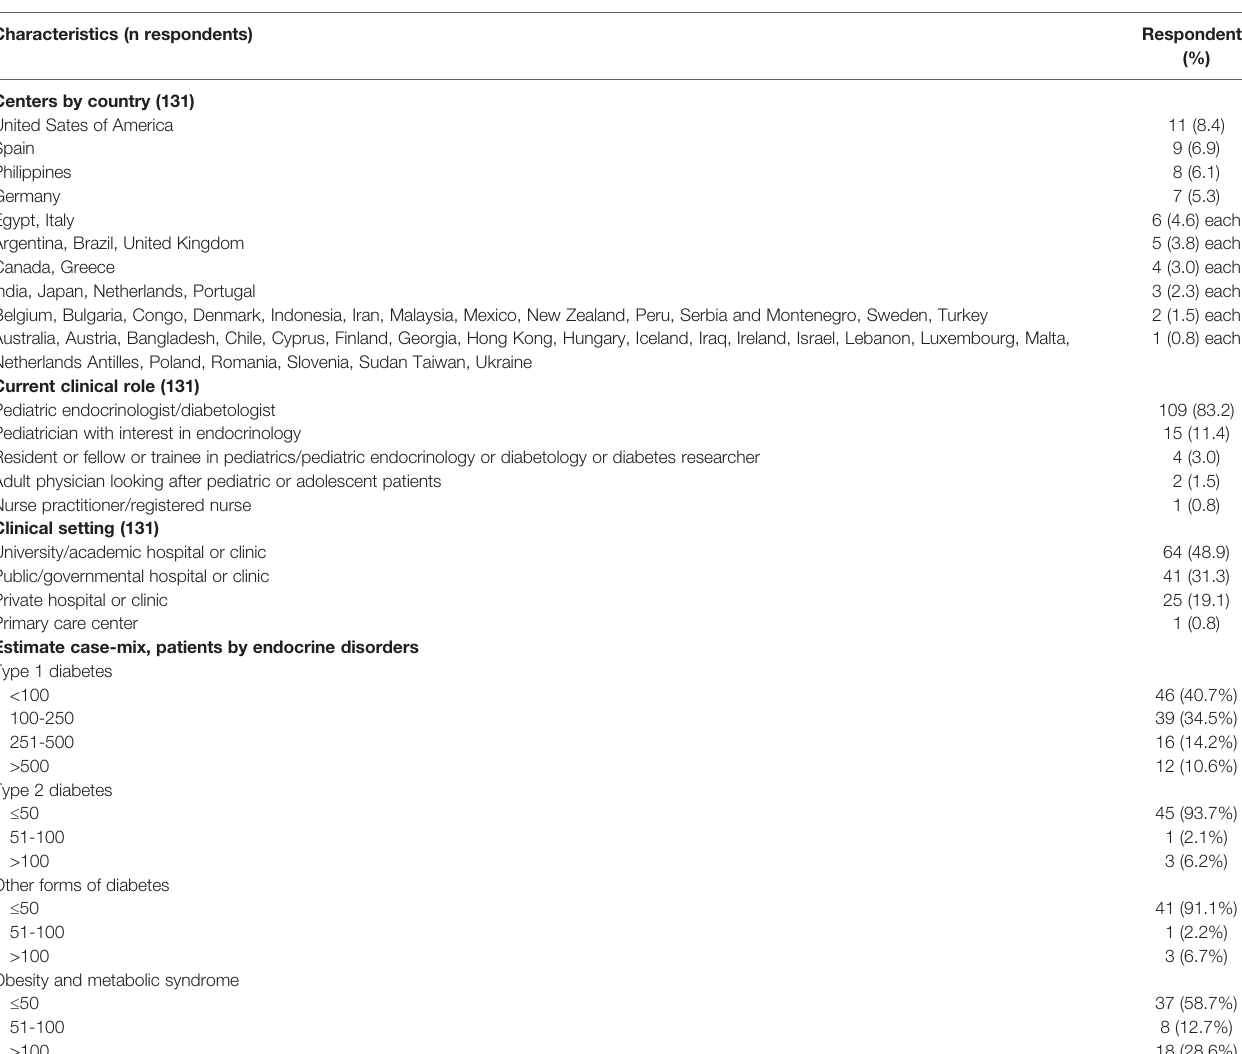
TABLE 1 | Endocrine clinical center characteristics and staff pro fi